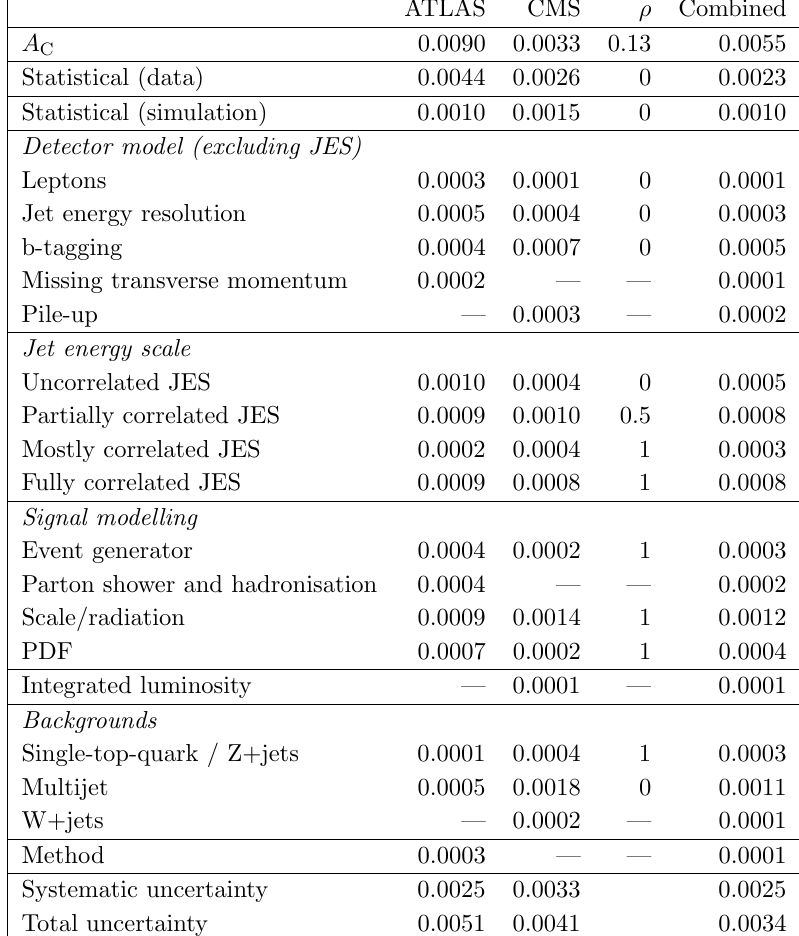
Table 3 . Uncertainties in the input measurements, assumed correlations (cid:26) between the uncertain- ties, and the resulting values for the uncertainties in the inclusive combination at breakdown of the systematic uncertainties of the ATLAS analysis (for the systematic uncertainties that are marginalised) corresponds to the expected uncertainties after